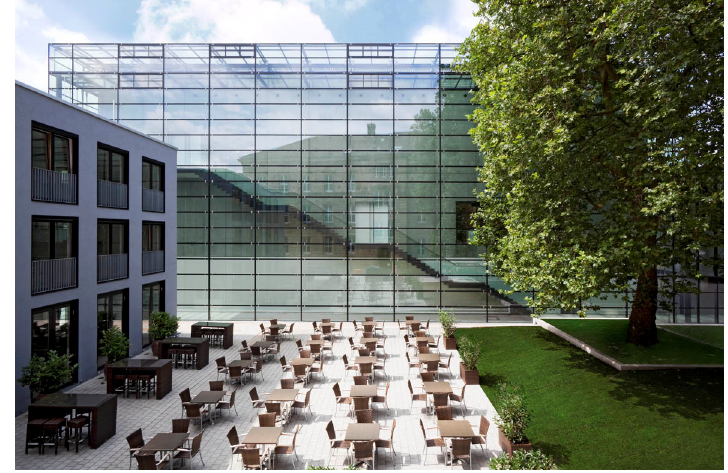
Figure 8: Emil Schumacher Museum,